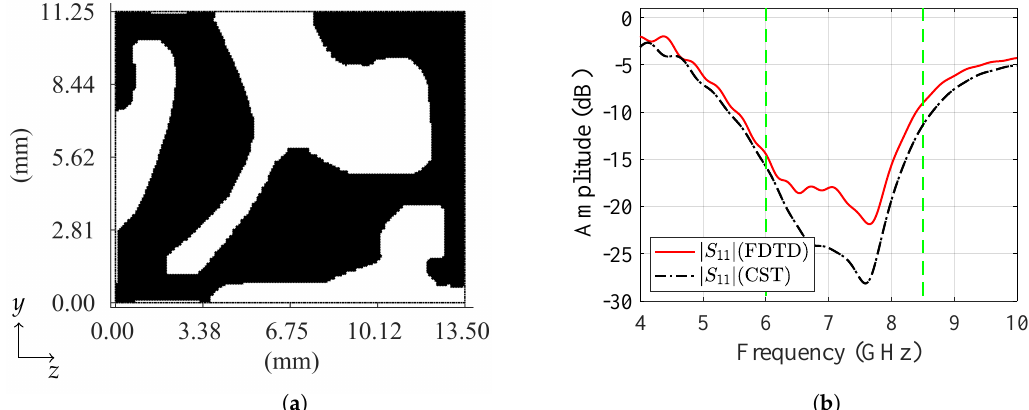
Figure 3. Reference antenna: ( a ) The shape of the antenna optimized to radiate over the frequency band 6.0–8.5 GHz. ( b ) Reflection coefficient of the antenna. The operational band is marked by the green dashed